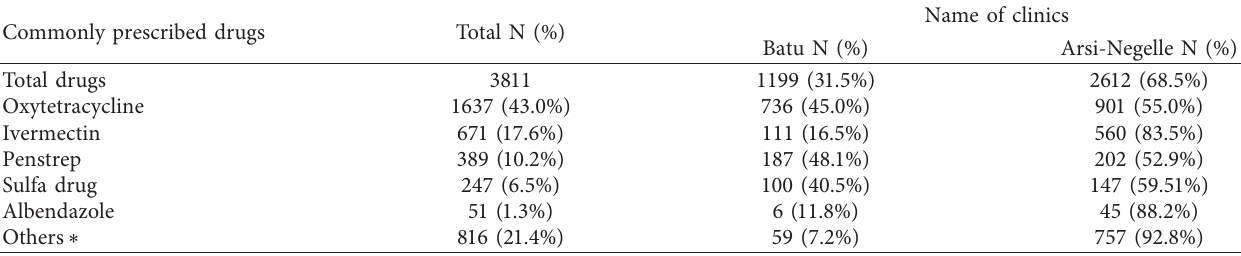
Table 1: Commonly prescribed drugs at Batu and Arsi-Negelle district veterinary clinics between the period of September 2012 to February 2015.